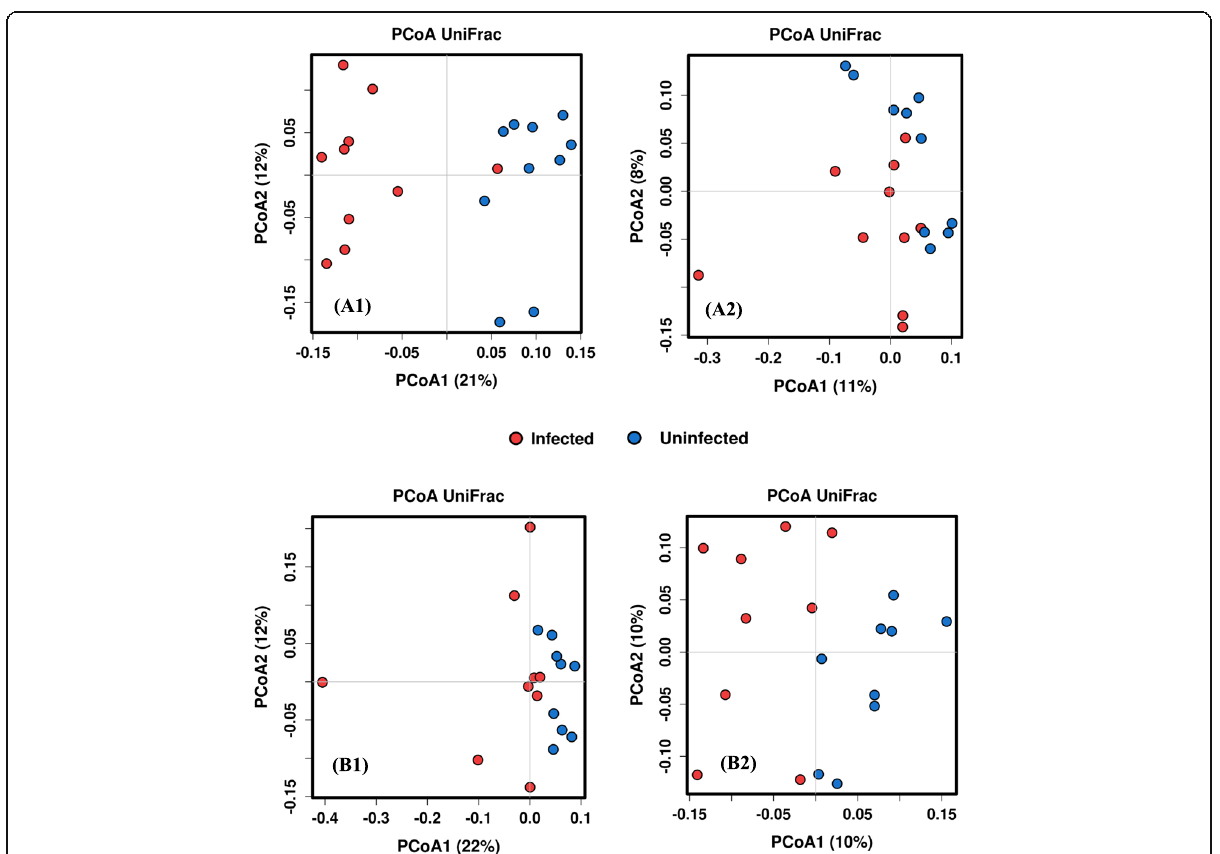
Fig. 5 Clustering of microbiome of infected and uninfected sheep based on 16S data . ( a ) high-burden; ( b ) low-burden sheep. PCoA plot of sheep based on weighted (A1 and B1) and unweighted (A2 and B2) UniFrac distance of gut bacterial composition. Each symbol represents an individual sheep